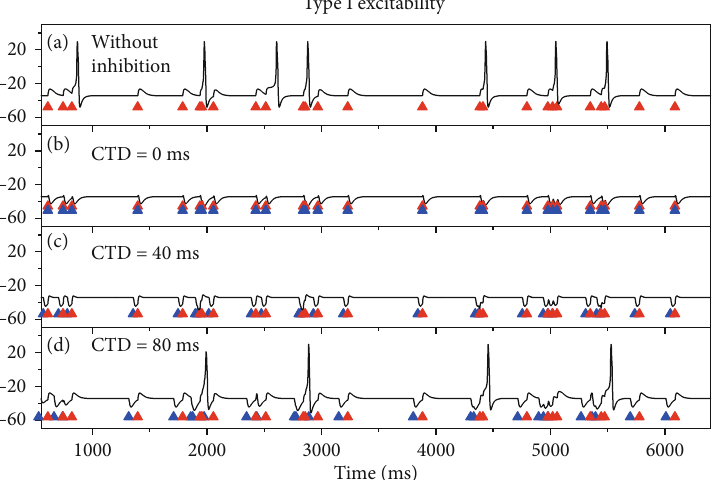
= 1 mS/cm 2 ). (a) Some random excitatory ex